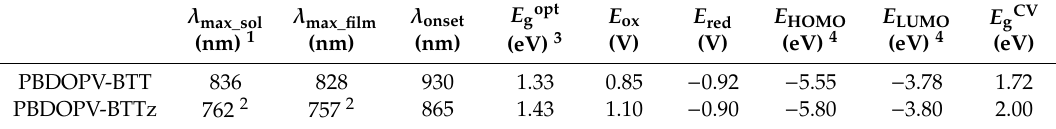
Figure 3. Normalized UV-vis-NIR absorption spectra of ( a ) BDOPV-benzothiadiazole-based copolymer (PBDOPV-BTT) and ( b ) PBDOPV-BTTz in dilute 1,2-dichlorobenzene solution and thin film states with optional thermal annealing. Table 1. Summary of physical properties of BDOPV-based polymers.